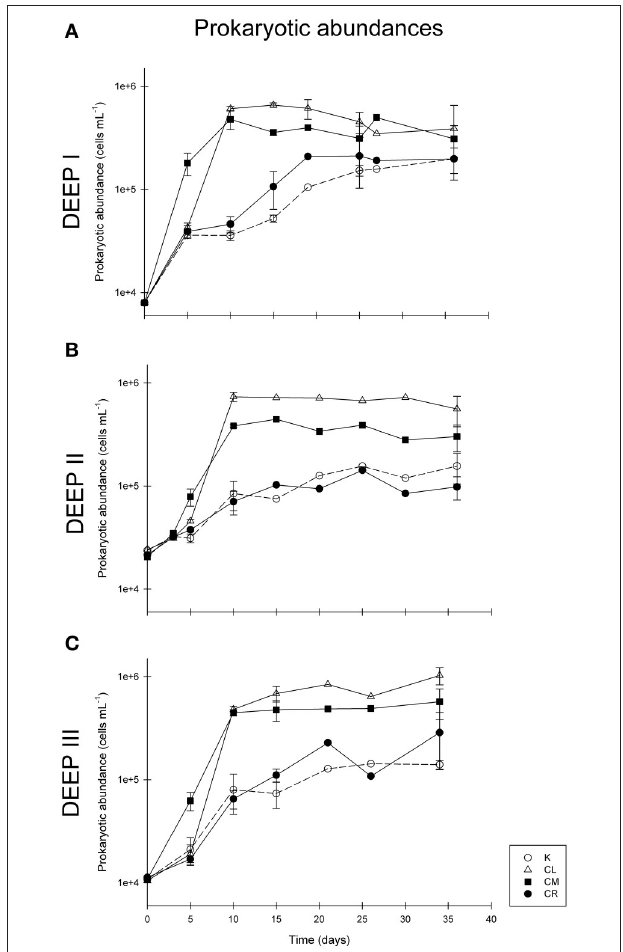
FIGURE 4 | Prokaryotic abundance (in cells mL − 1 ) during experiments DEEP I (A), DEEP II (B), and DEEP III (C). Vertical lines show standard deviations of 3